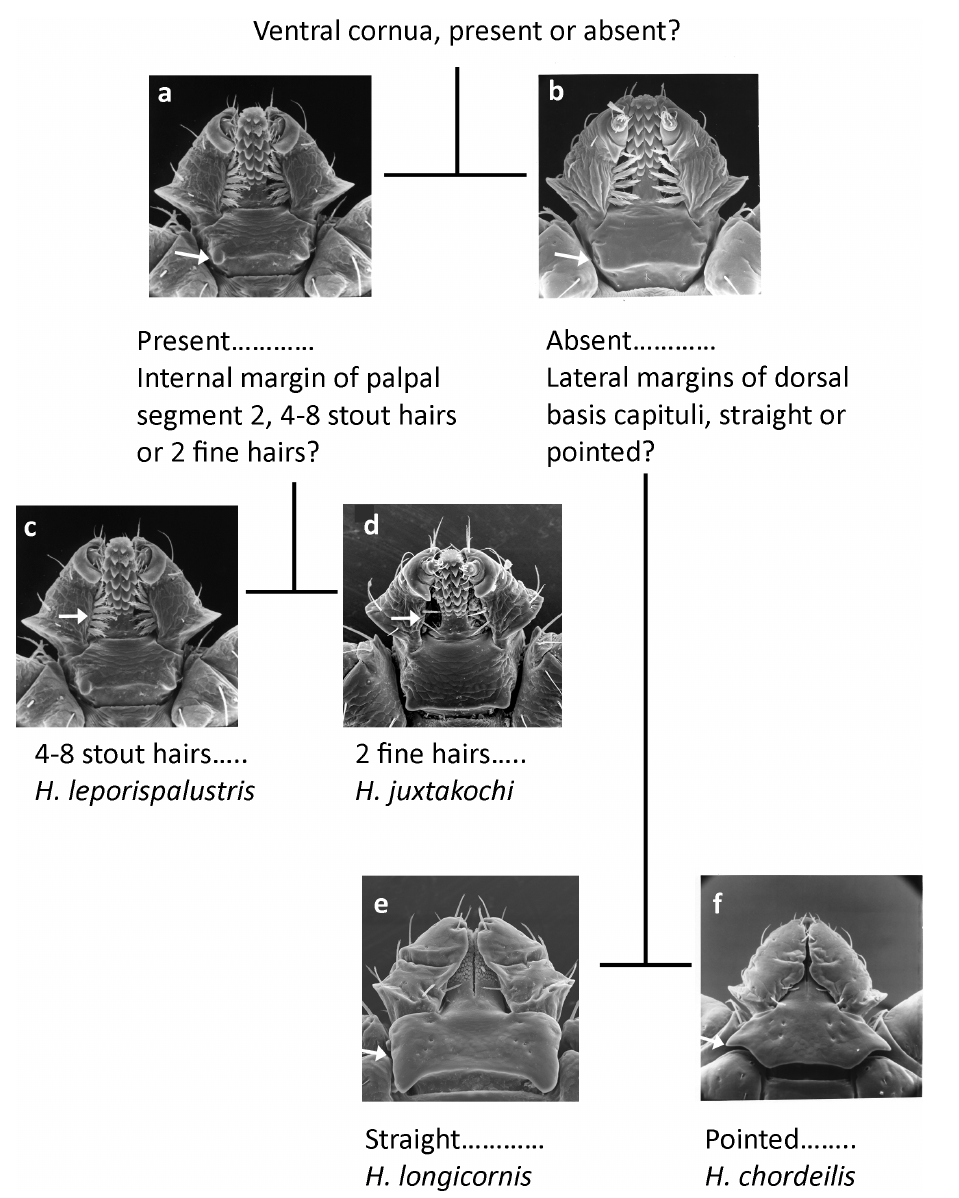
Figure 6. Pictorial key to nymphs of Haemaphysalis spp. occurring in North